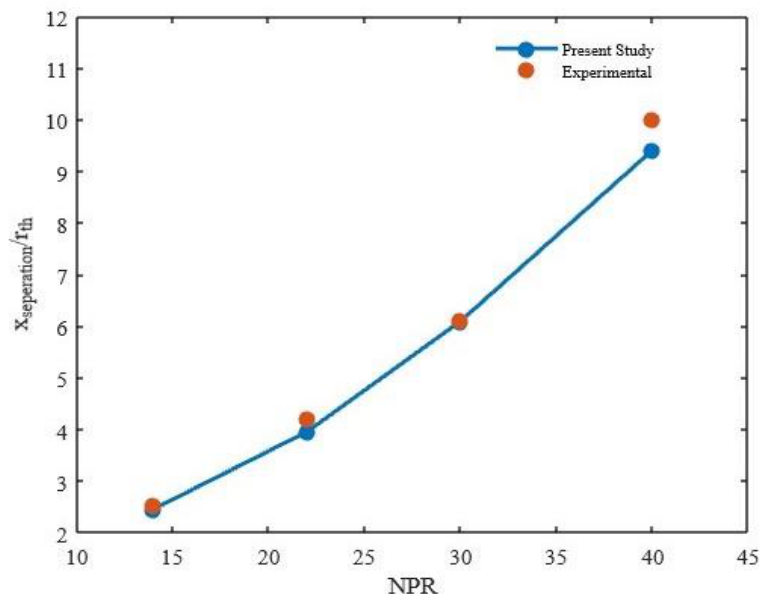
Figure 4. Comparison of simulation and experimental [39] separation points (determined based on wall-shear prediction) for different NPRs.